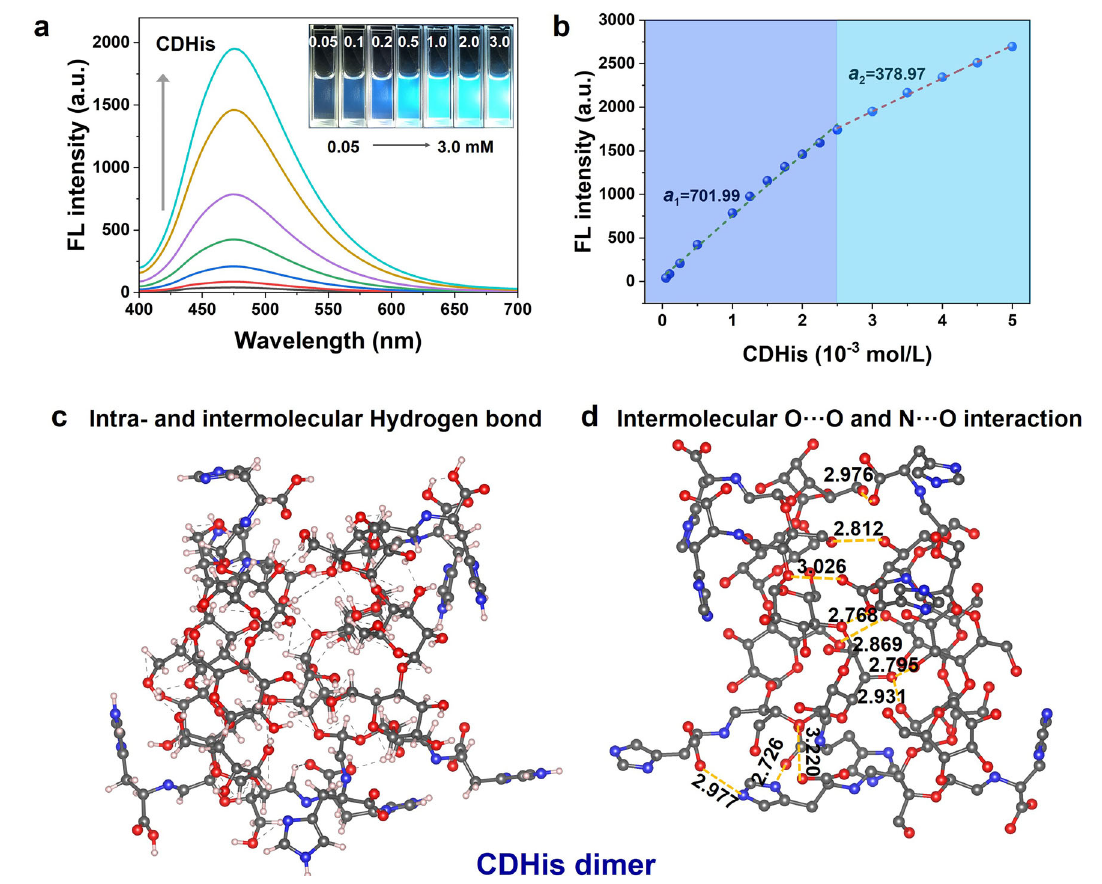
Fig. 4 | Fluorescence and intermolecular interactions of CDHis in dilute solu- tion. a Concentration-dependent FL spectra of CDHis in aqueous solution ( λ ex =390nm). The inset shows the photographs of CDHis solutions under 365nm